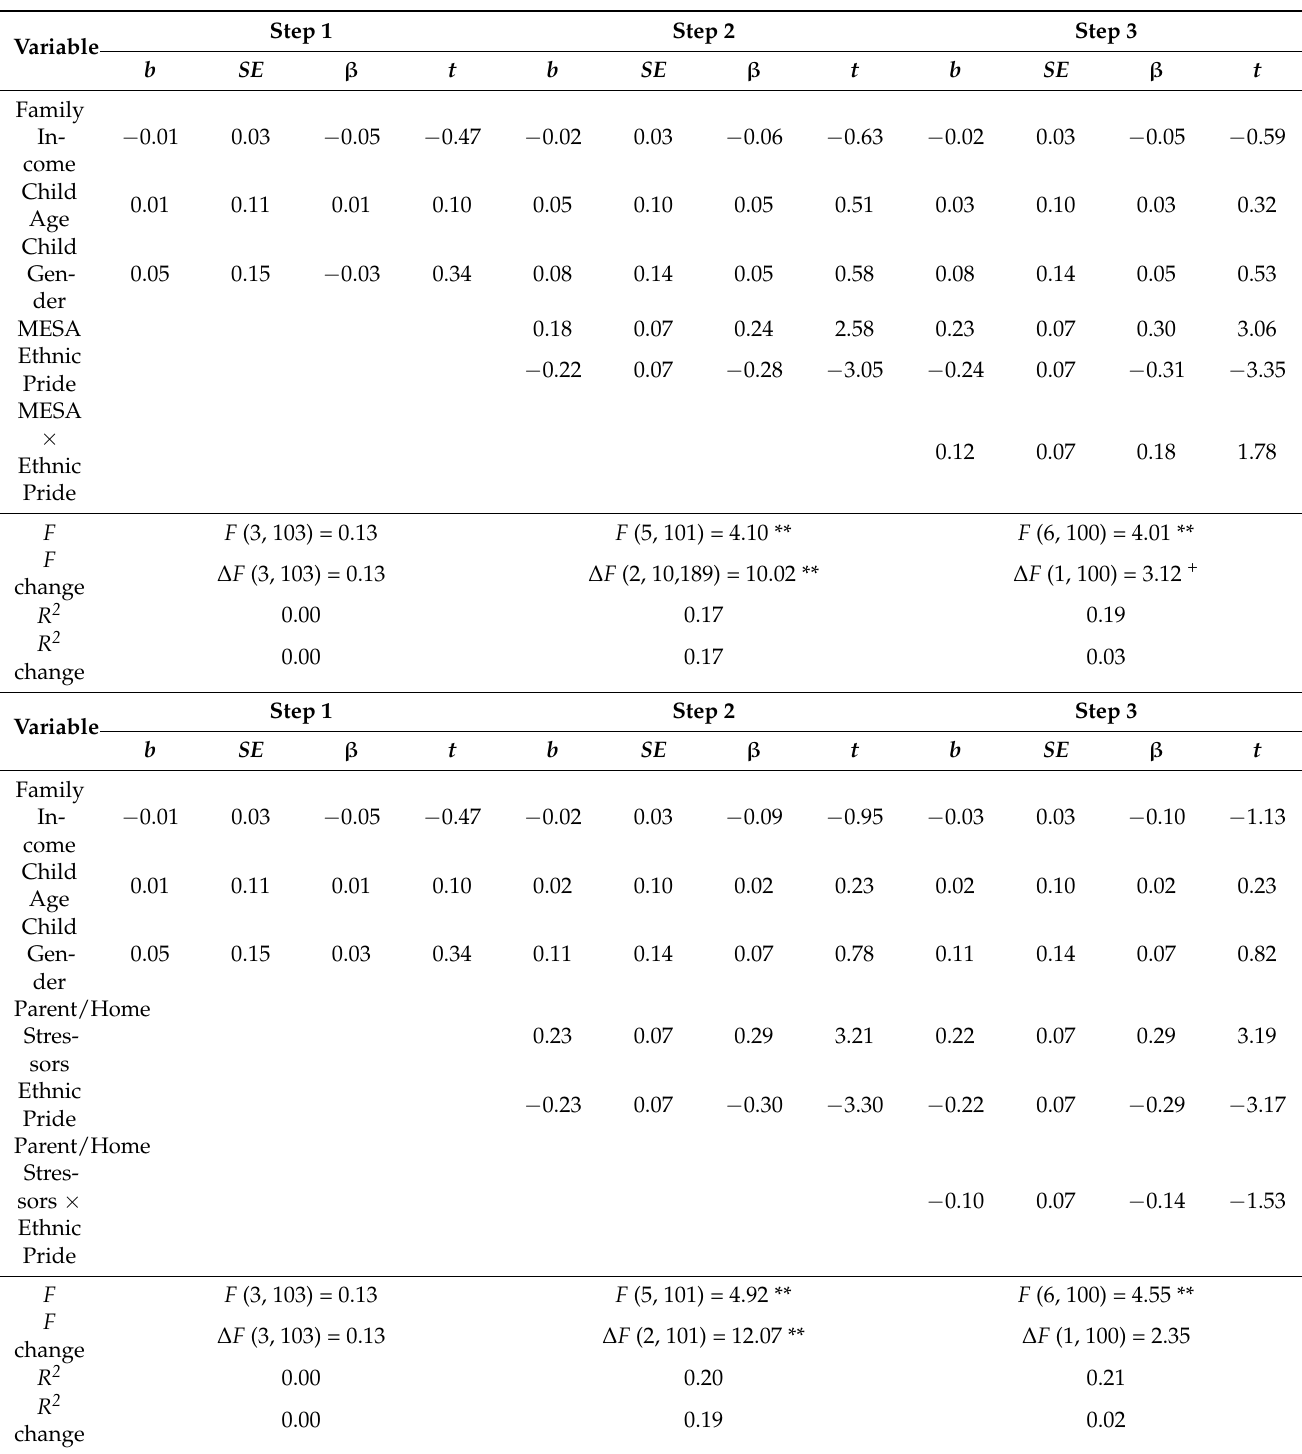
Table 2. Moderated regression analysis of the role of ethnic pride on child depressive